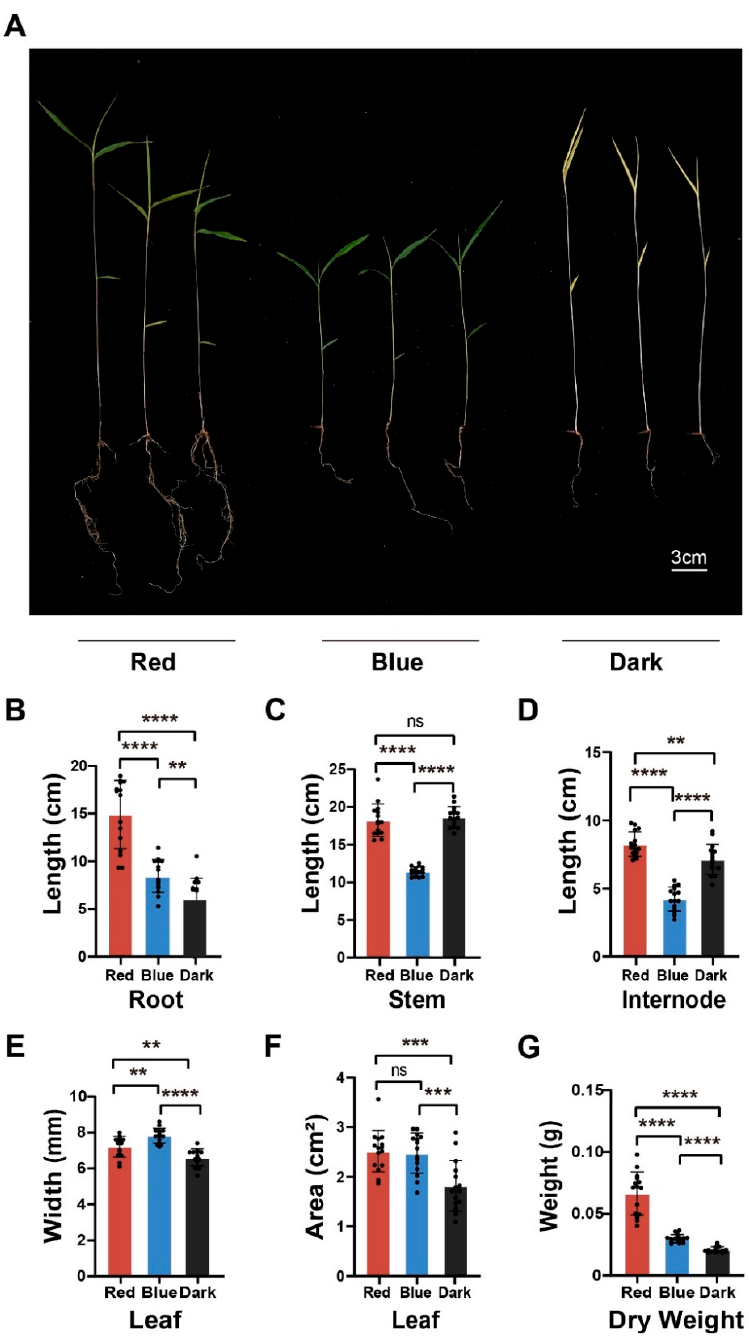
Figure 1. Effects of red and blue light treatments on the growth and development of moso bamboo seedlings. ( A ) The representative phenotypic image of moso bamboo seedlings under different light treatments. After the seeds germinated in the dark, they were transferred to red light (650 nm), blue light (450 nm) and dark conditions for 14 days. Scale bar = 3 cm. ( B – G ) Quantification of the root length (the length of the primary root) ( B ), stem length ( C ), internode length (the length between the second and third leaf) ( D ), leaf width (the width of the widest position of the second leaf) ( E ), leaf area (the area of the second leaf) ( F ), dry weight ( G ) of the bamboo seedlings treated with different light conditions. Data are presented as mean ± SD ( n = 15 seedlings). Significant differences were analyzed by two-tailed Student’s t -test ( ns p > 0.05, ** p < 0.01, *** p < 0.001, **** p <